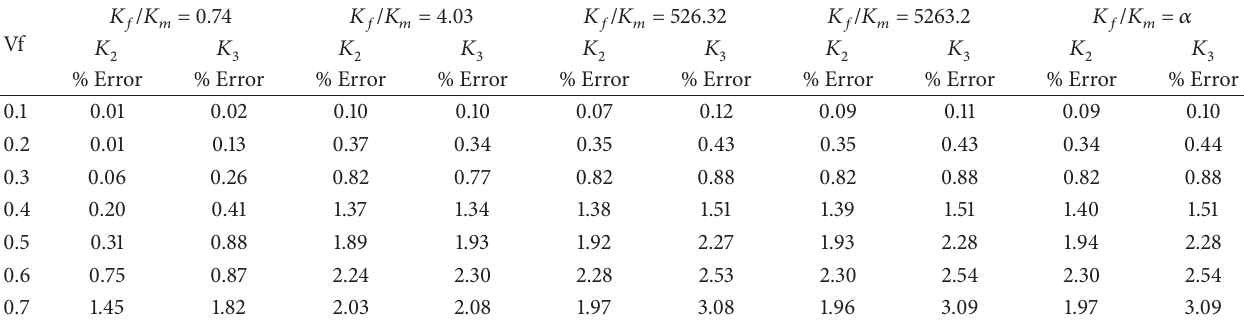
Table 3: % Error between macro- and micromechanics approach results for composite with one out of four fibres of unit cell fully debonded. 𝐾 𝐾 𝑓 / 𝑚 = Vf